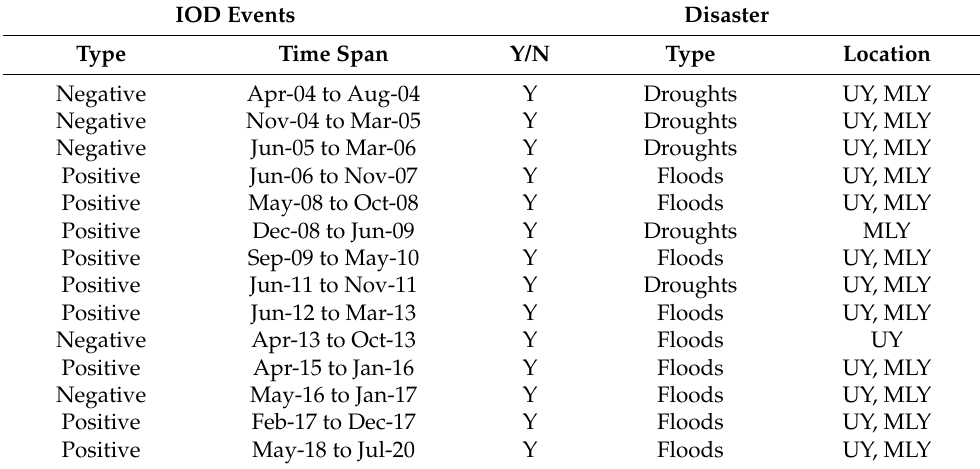
Table 8. The drought and flood events statistics during and after IOD events in the YRB. IOD Events Disaster Type Time Span Y/N Type Location Negative Apr-04 to Aug-04 Y Droughts UY, MLY Negative Nov-04 to Mar-05 Y Droughts UY, MLY Negative Jun-05 to Mar-06 Y Droughts UY, MLY Positive Jun-06 to Nov-07 Y Floods UY, MLY Positive May-08 to Oct-08 Y Floods UY, MLY Positive Dec-08 to Jun-09 Y Droughts MLY Positive Sep-09 to May-10 Y Floods UY, MLY Positive Jun-11 to Nov-11 Y Droughts UY, MLY Positive Jun-12 to Mar-13 Y Floods UY, MLY Negative Apr-13 to Oct-13 Y Floods UY Positive Apr-15 to Jan-16 Y Floods UY, MLY Negative May-16 to Jan-17 Y Floods UY, MLY Positive Feb-17 to Dec-17 Y Floods UY, MLY Positive May-18 to Jul-20 Y Floods UY, MLY